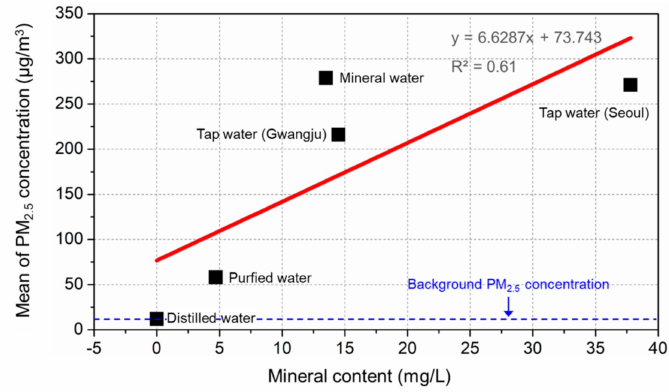
Figure 9. Comparison of the mean of the PM 2.5 concentration and mineral